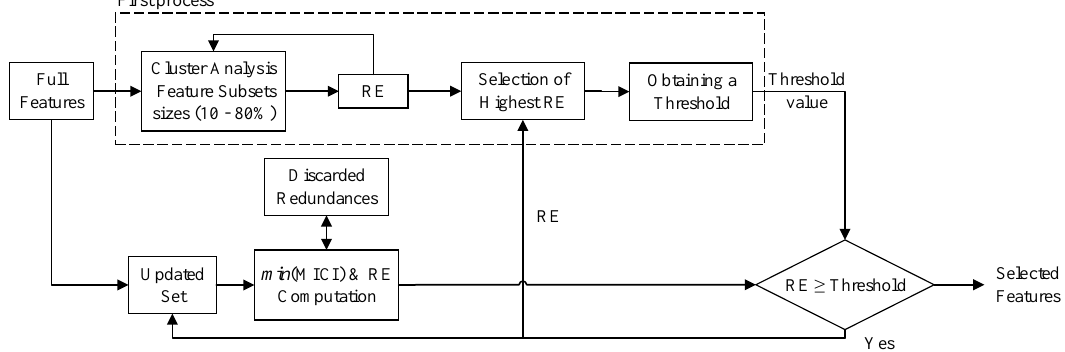
Figure 2. Representation of the proposed method for feature selection, using the Maximal Information Compression Index (MICI), and the Representation Entropy (RE)